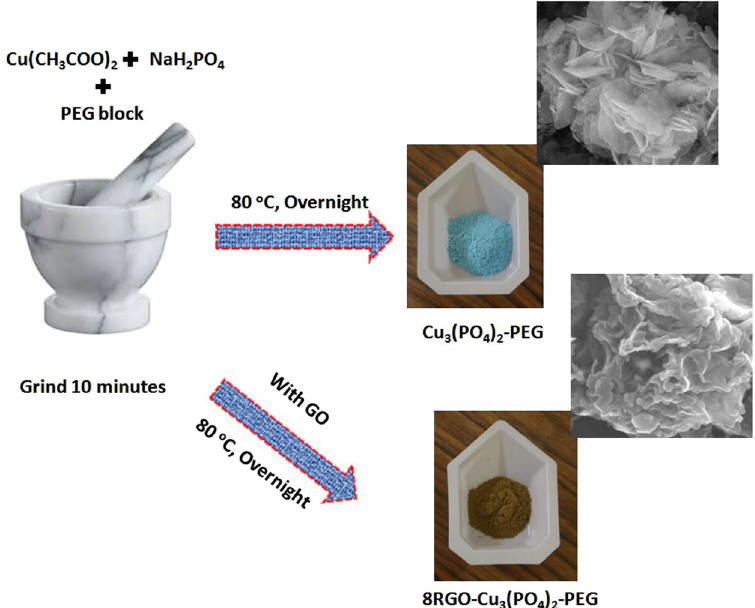
Figure 18. Pictorial representation of Cu 3 (PO 4 ) 2 -PEG